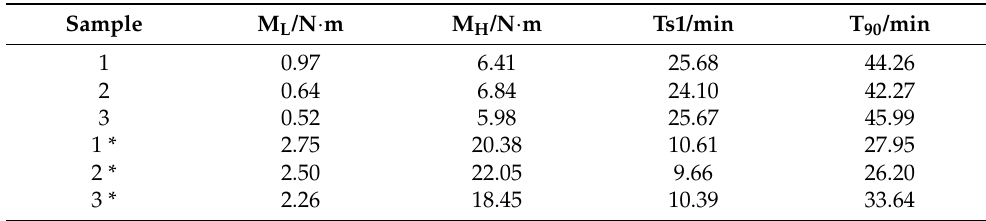
Table 2. Vulcanization data of NR/Fiber compounds at 143 ◦